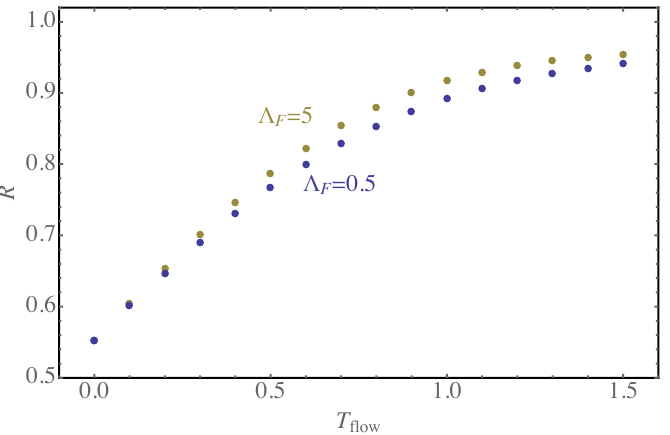
Figure 10 . Complex contours J (cid:3) ( T (cid:13)ow ) for the U(1) one-link model with (cid:20) = 2. We set (cid:3) B = 10. The saddle points, which in the left (cid:12)gure are intersected by the Lefschetz thimble, are denoted by the blue dots while zeros of the fermion determinant are shown as red squares. The dashed black curves show (cid:13)ow lines with initial condition on the real axis.